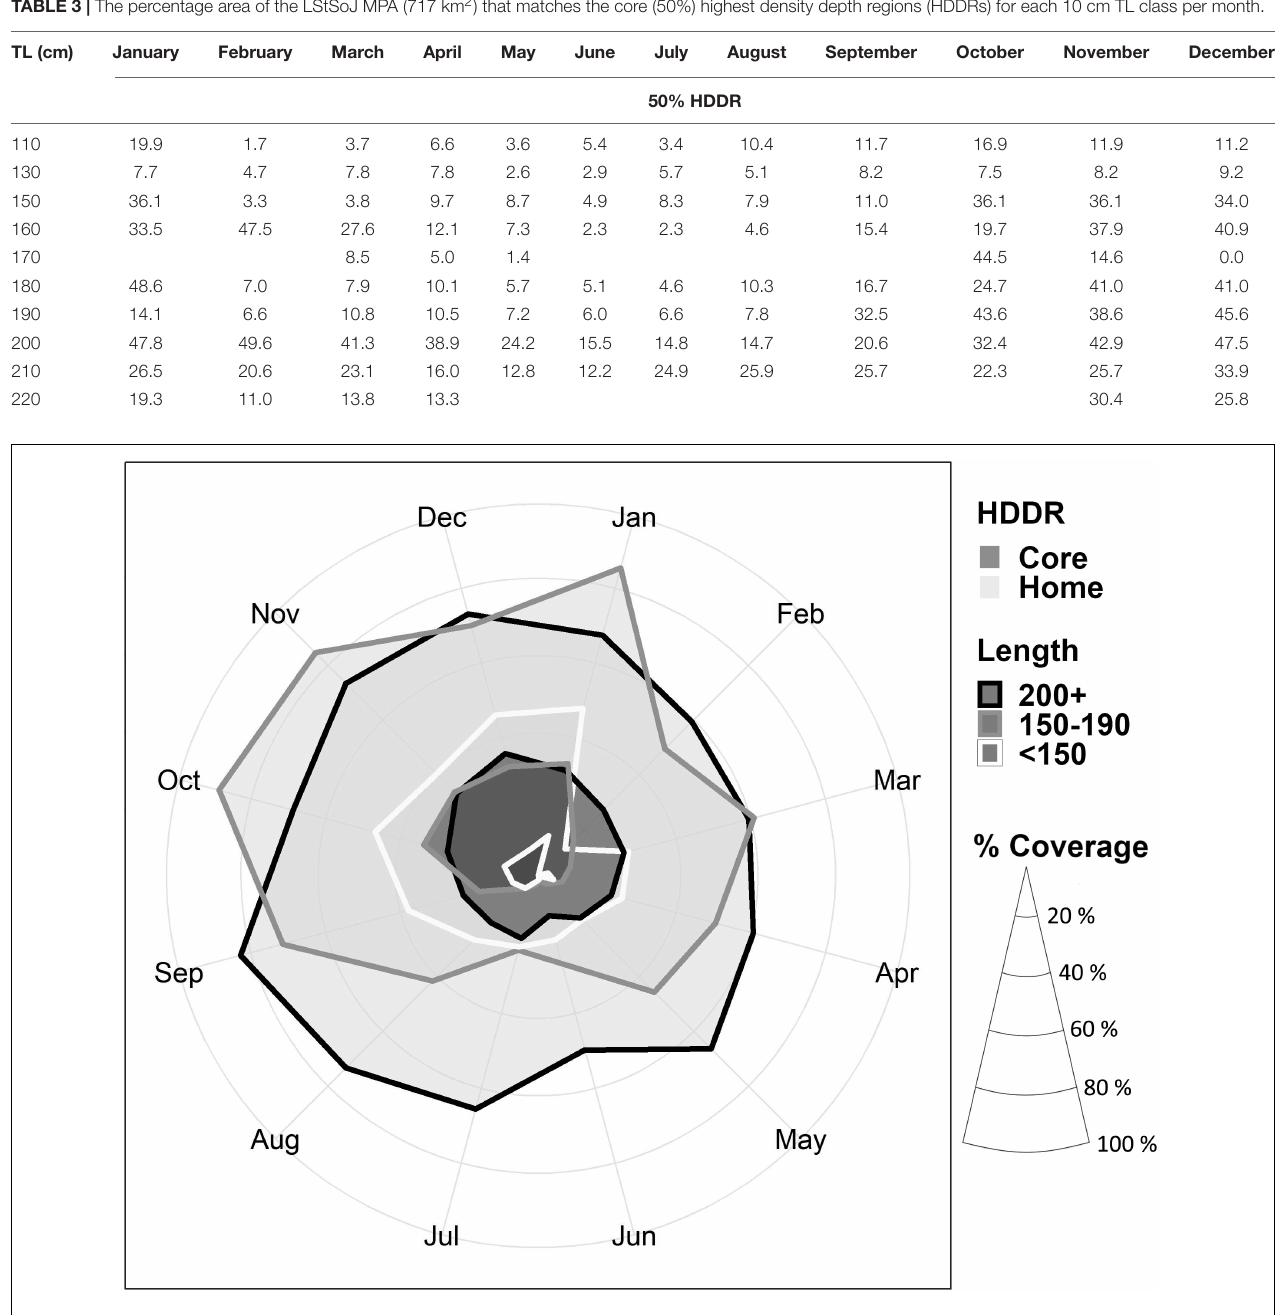
FIGURE 8 | Percentage cover in the MPA of areas associated with home and core HDDRs. Length classes grouped into < 150, 150–190, and > 200 cm total length to assist